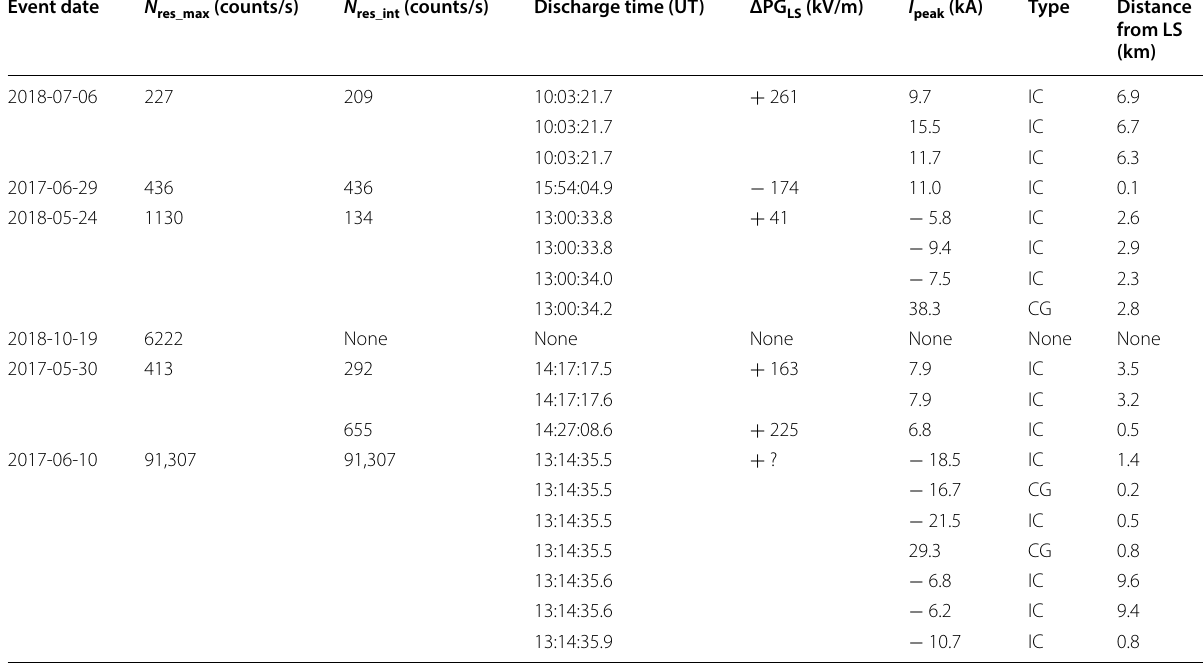
Table 2 Basic characteristic of the significant TGEs and lightning that terminated them Event